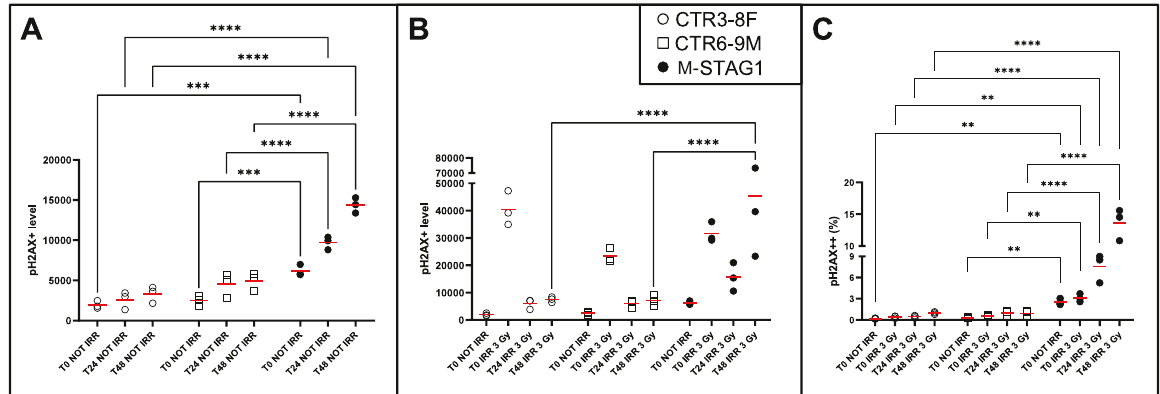
Fig. 2 γ H2AX phosphorylation status before and after X-ray irradiation. Cells were seeded at different, previously established, concentrations, in order to perform the experiments in an exponential growth phase (0.1 × 10 6 /ml for CTR3-8F, 0.22 × 10 6 /ml for CTR6-9M and 0.18 × 10 6 /ml for M-STAG1). A shows that γ H2AX phosphorylation status of M-STAG1 is higher at basal conditions and increases during timepoints compared to control LCLs (T0: 2.8X, p < 0.001; T24: 2.7X, p < 0.0001; T48: 3.5X, p < 0.0001; MFI M-STAG1 over MFI control LCLs). γ H2AX phosphorylation remains at higher levels also after irradiation [3Gy] ( B , T24: 2.6X, ns; T48: 6.3X, p < 0.0001 [3Gy]; MFI M-STAG1 over MFI control LCLs, normalized on the percentage of γ H2AX + cells). The percentage of pH2AX ++ subpopulation, recognized only for M-STAG1 either at basal level (10.5X, p < 0.01; percentage of pH2AX ++ M-STAG1 cells over percentage of pH2AX ++ control LCLs cells) or after irradiation (T0: 6.2X, p < 0.01; T24: 10.6X, p < 0.0001; T48: 14.1X, p < 0.0001; percentage of pH2AX ++ cells M-STAG1 over percentage of pH2AX ++ cells controls ’ LCLs), shows the same trend ( C ). ( n = 3 replicates. Statistical analysis performed by one-way Anova with Bonferroni ’ s multiple comparison correction. * <0.05; **<0.01 ***<0.001;